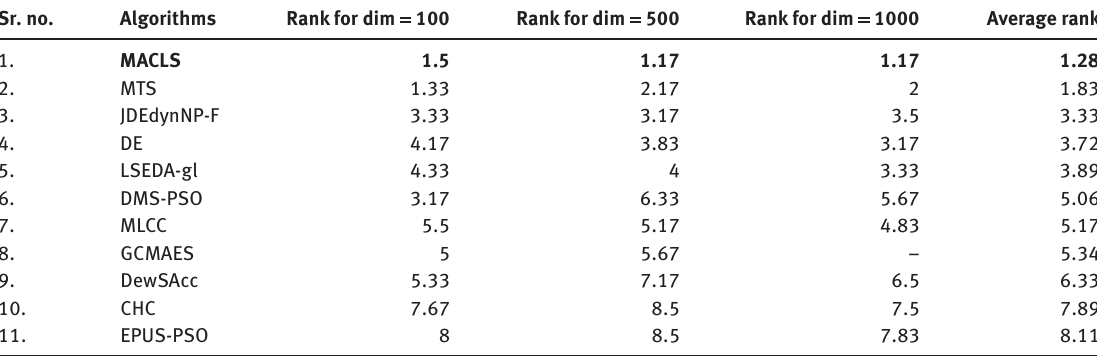
Table 9: Mean Ranking of Algorithms Over All Dimensions. Sr.